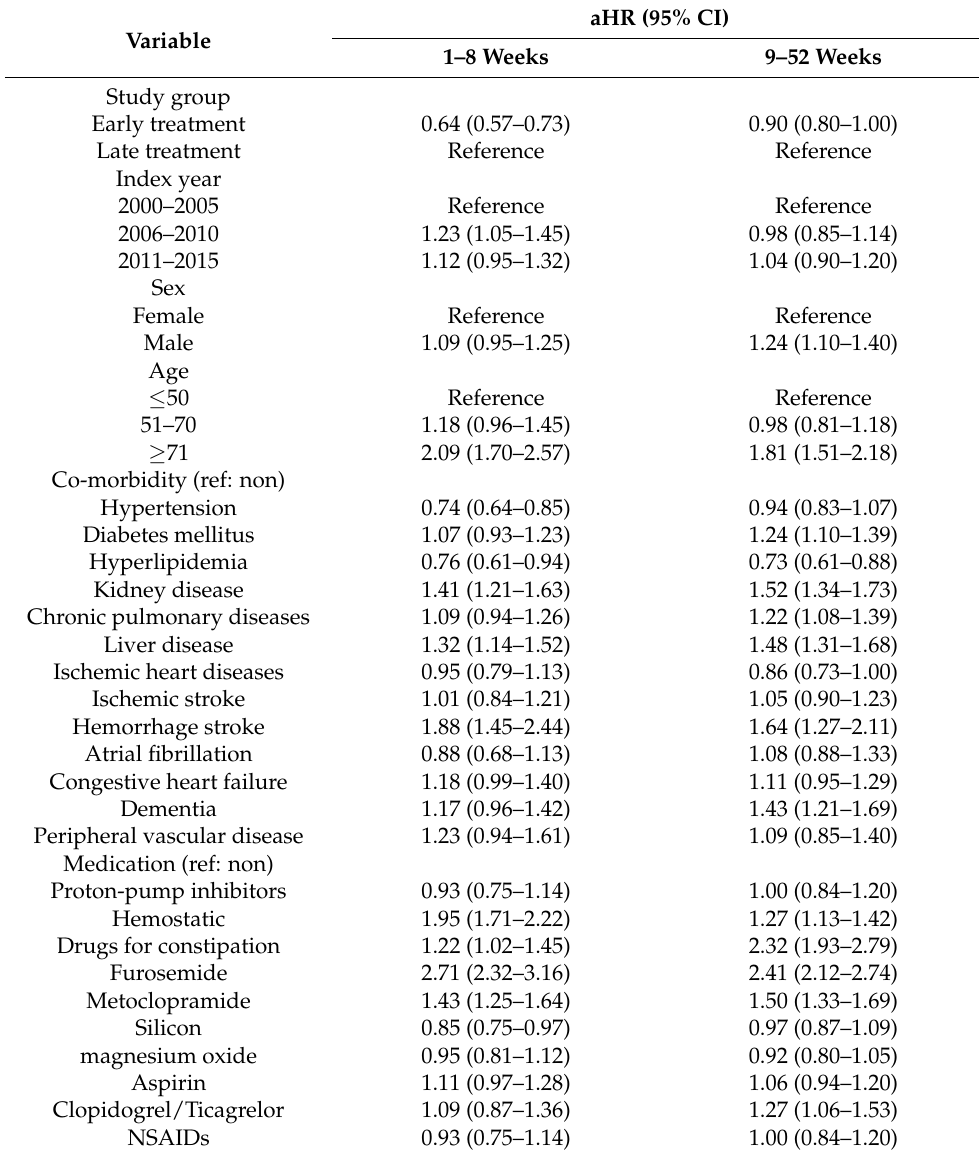
Table 2. Multiple Cox regression to estimate the hazard ratio for the 52 week mortality